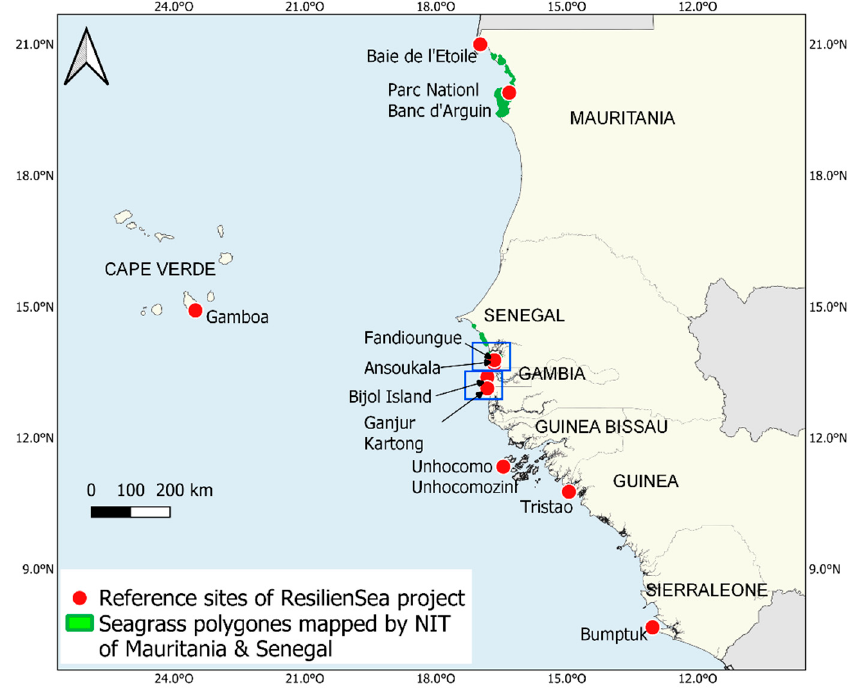
Figure 9. Seagrass distribution and extent in the whole study area.